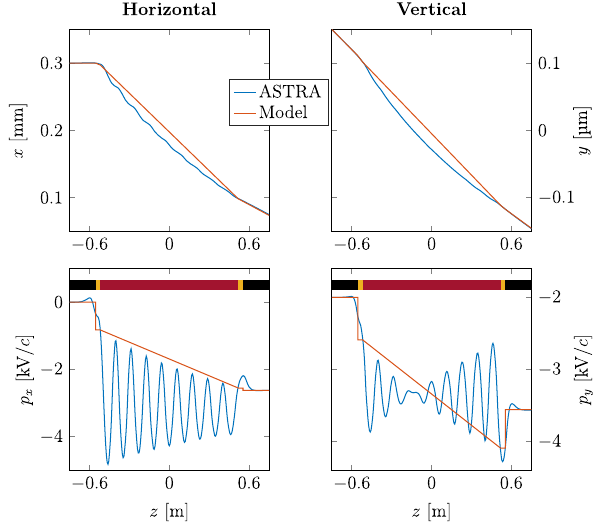
FIG. 9. Particle trajectory through a TESLA cavity as calcu- lated by ASTRA (blue) and the linear beam dynamics model [red, cf. Eq. (22)]. Plotted are the horizontal (left) and vertical (right) positions (upper plots) and momenta (lower plots), respectively, as a function of the longitudinal coordinate z . The cavity is centered at z ¼ 0 m. The colored bars in the lower plots illustrate the different transfer matrices of the model. Beam initial and final energy is 10 MeV and 24 MeV, respectively.